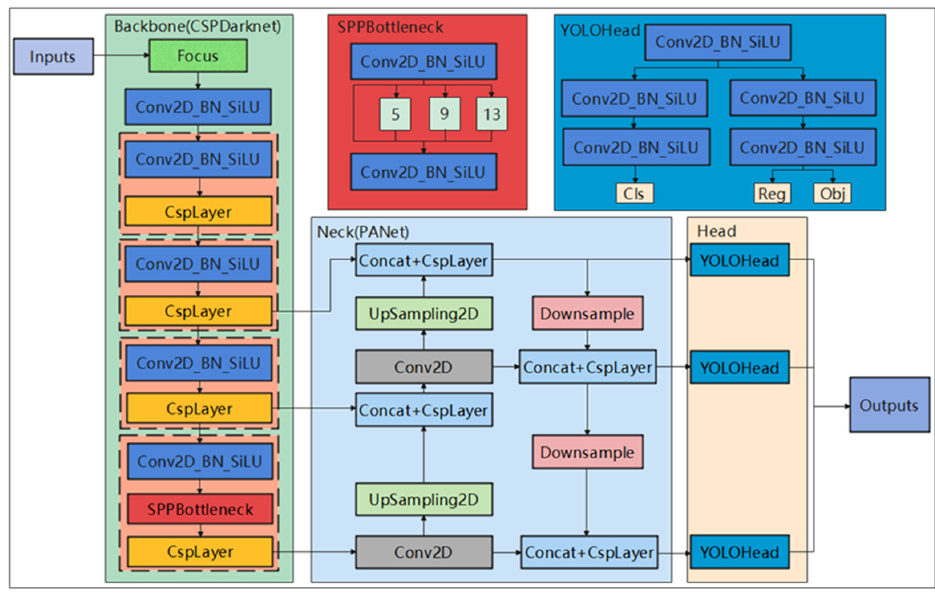
Figure 1. Overall structure of YOLOX algorithm.